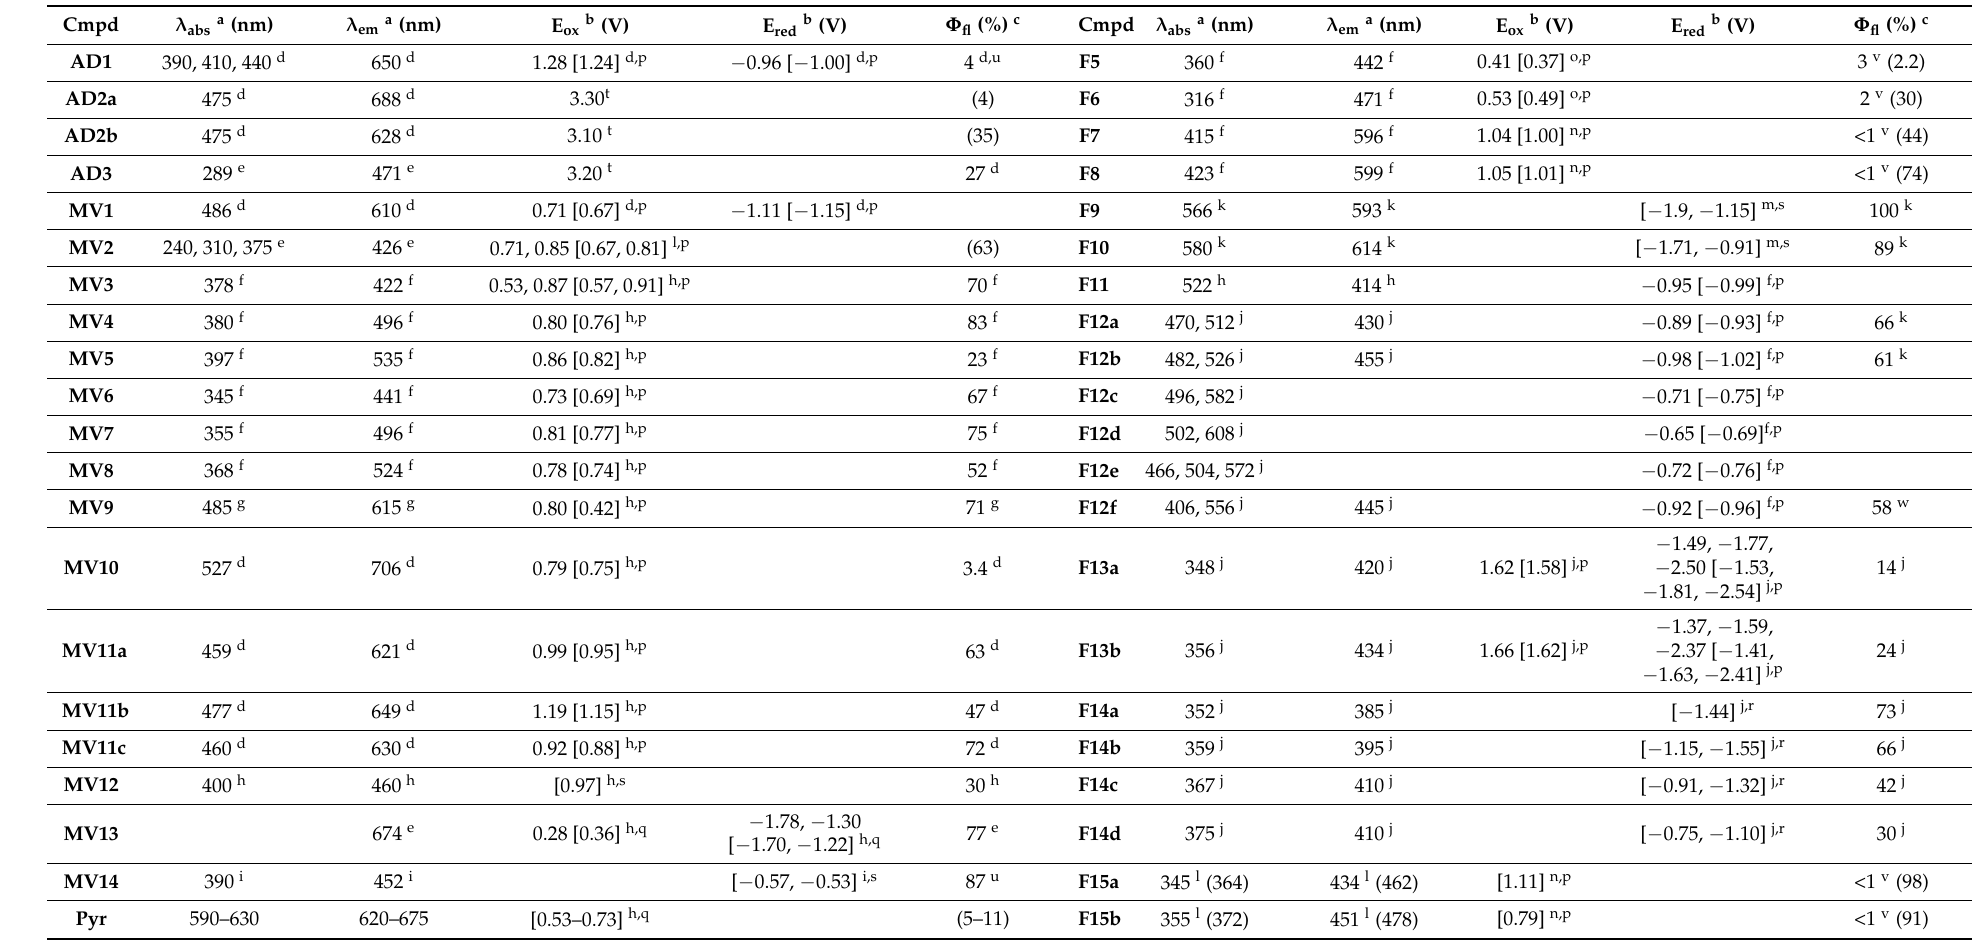
Table 1. Collective spectroscopic and electrochemical data of molecular